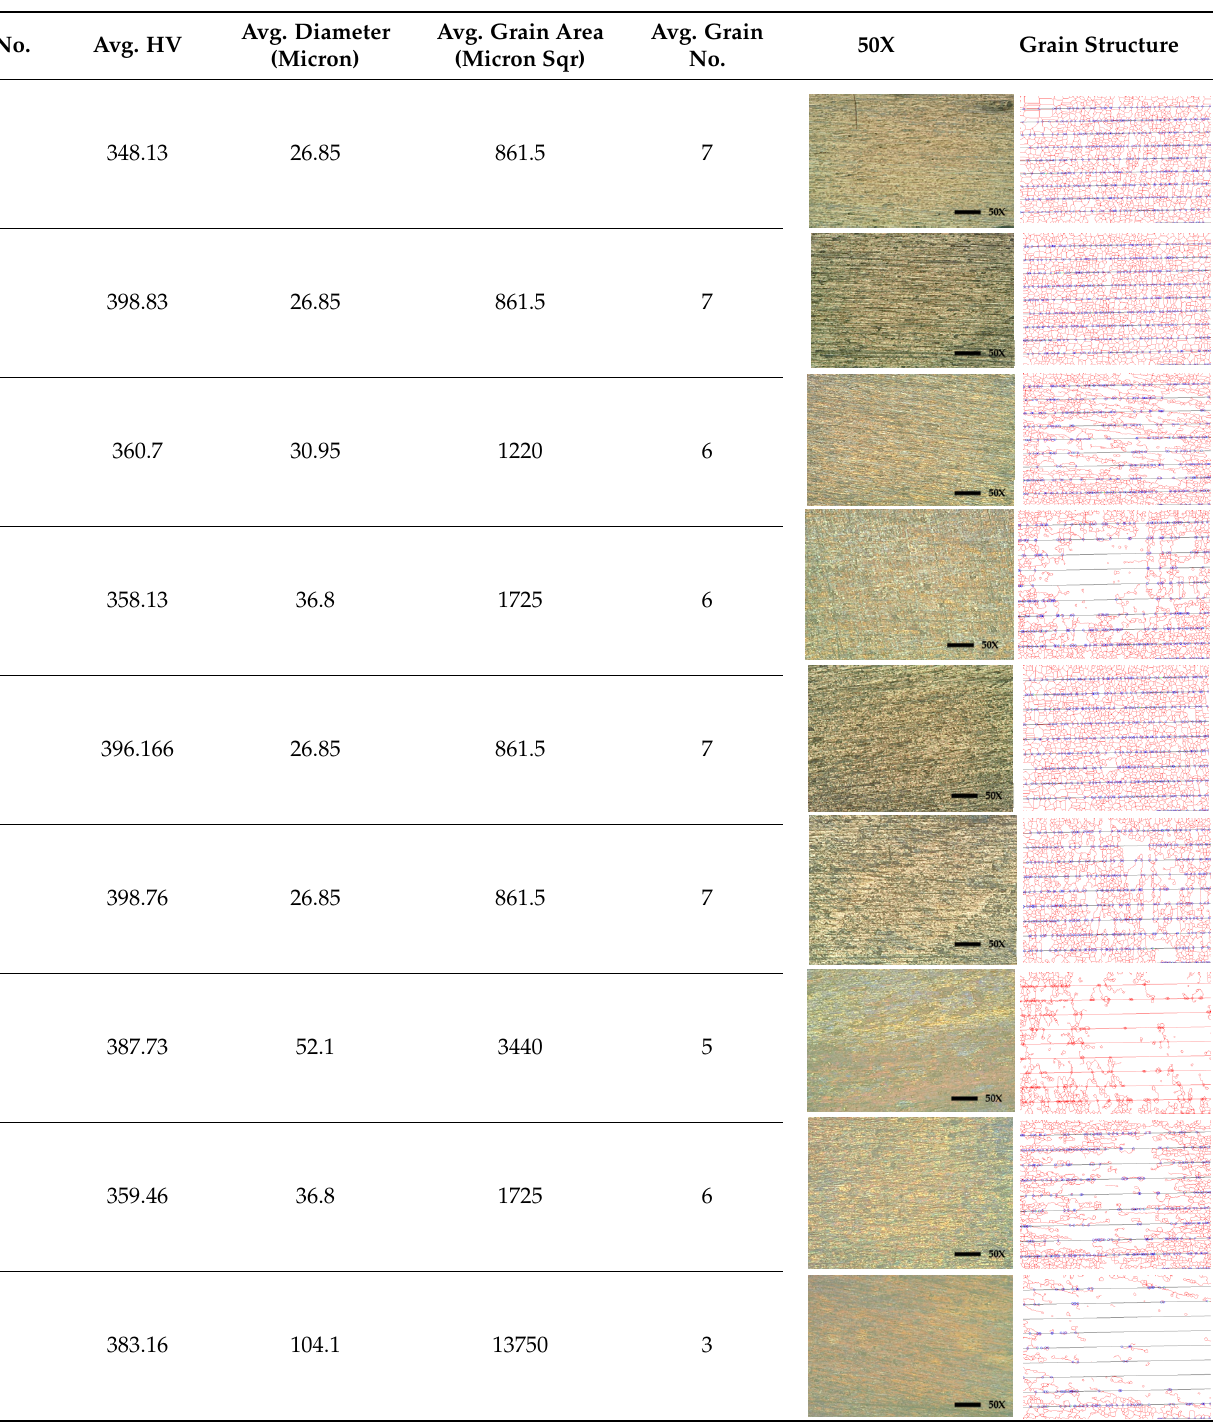
Table 5. After Heating Hardness and Grain size.